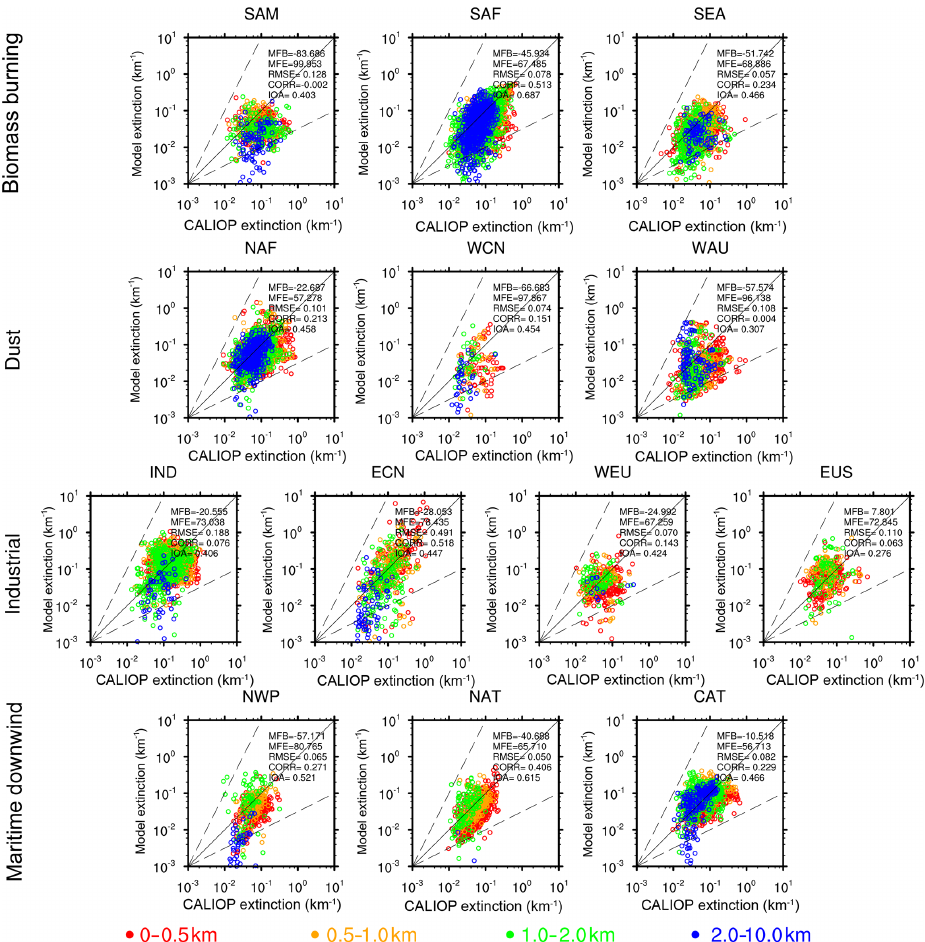
Figure 4. Scatter plots of the hourly modeled aerosol extinction coefficients at 550nm (km − 1 ) versus the CALIOP-observed ones at 532nm over the 13 selected regions during November 2016 for the FR